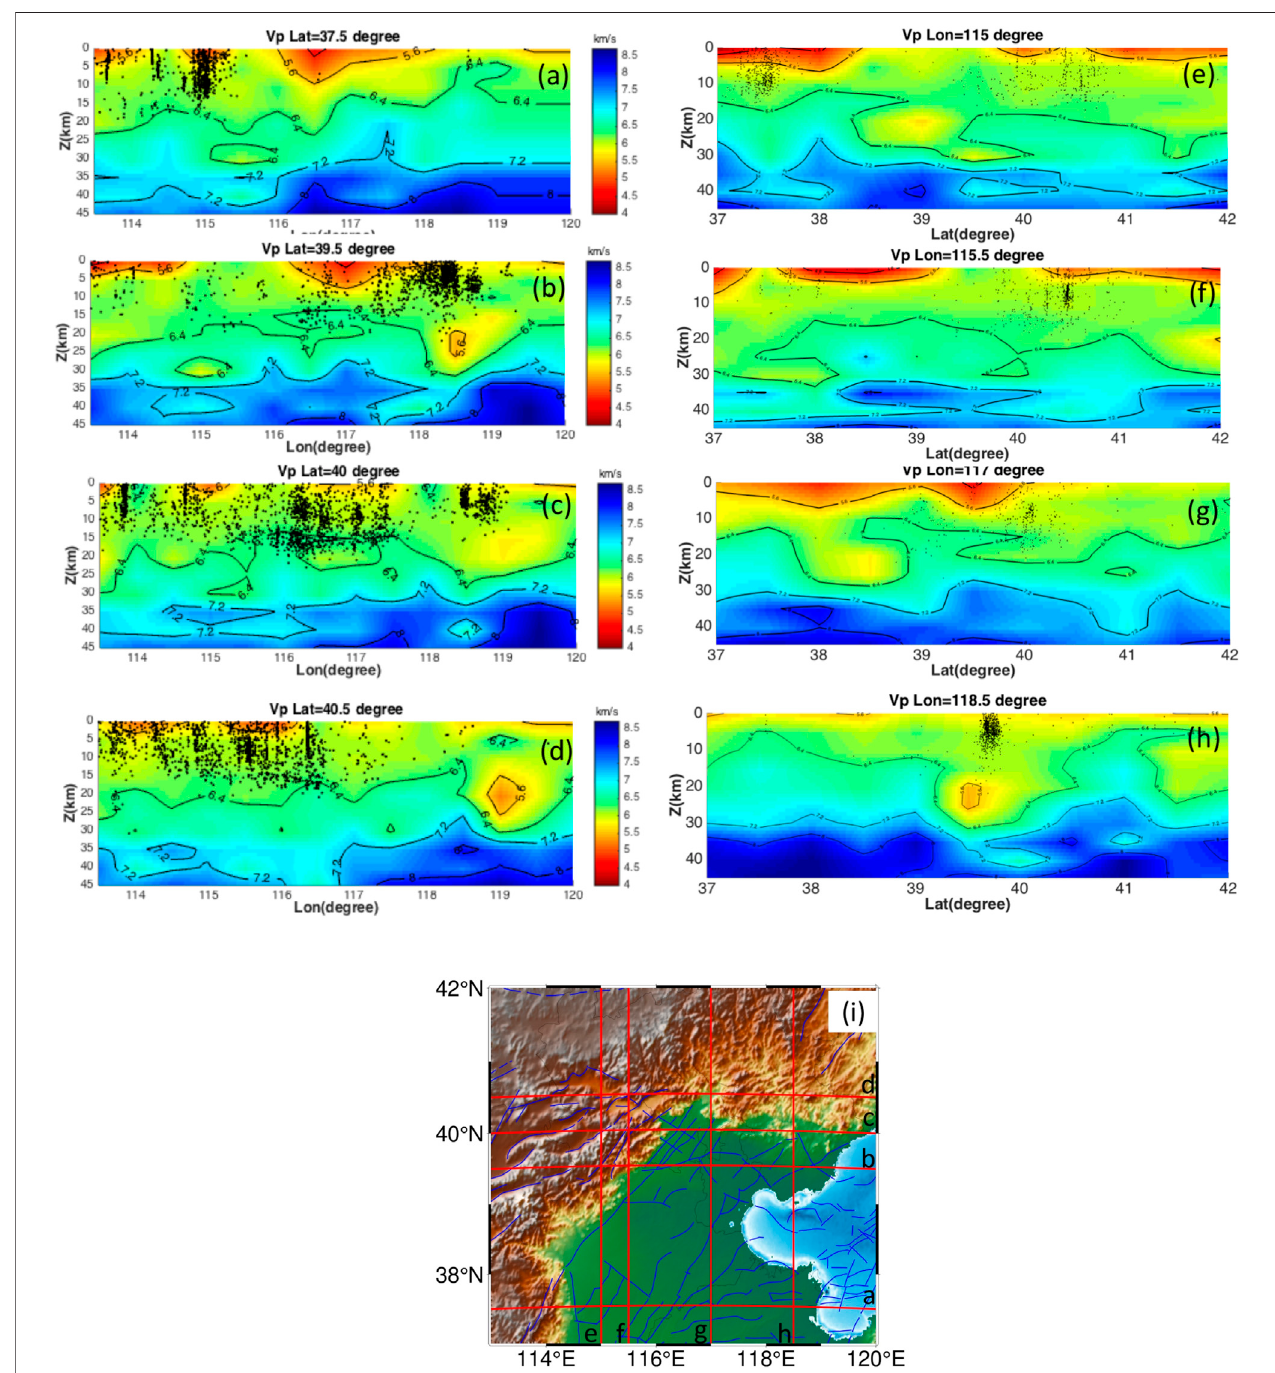
FIGURE8|(A – H) Eight vertical cross-sectionsofP-wave velocity images. Blueand red colorsdenote high andlowvelocities,respectively. Blackdotsindicate the relocated seismicity. The locations of the pro fi les are shown as solid red lines in (I) . The solid blue curve in (I) indicates the major active faults.